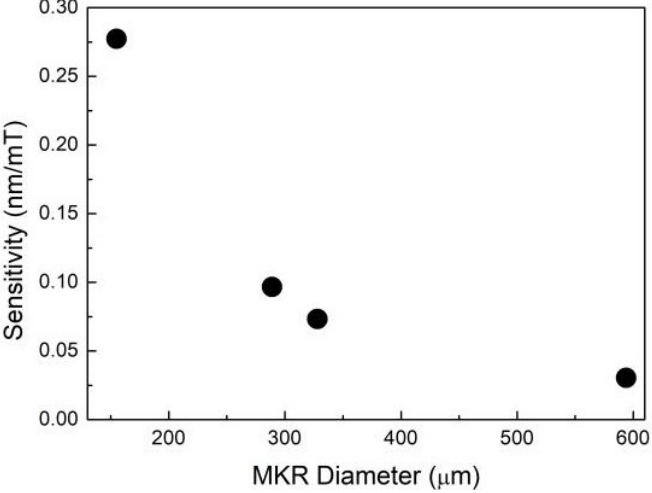
Figure 5. Magnetic field sensitivity of the MKR sensors as a function of the MKR ring diameter.